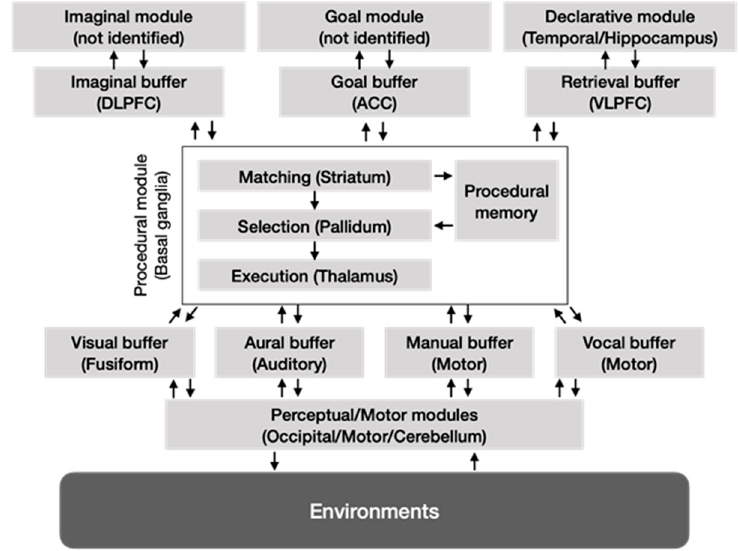
Figure 1. Schematic diagram of the ACT-R cognitive architecture. The neural location of the modules and buffers are indicated in parenthesis.